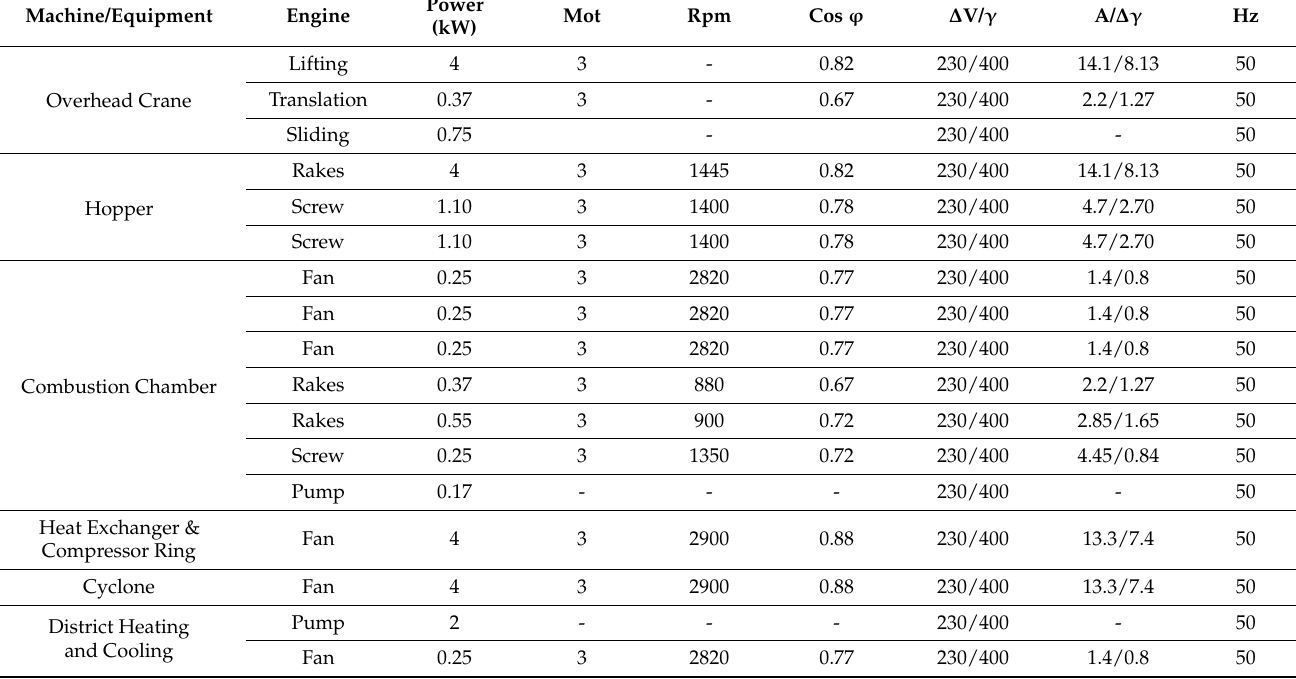
Table A2. ReCiPe Midpoint—characterisation—polygeneration